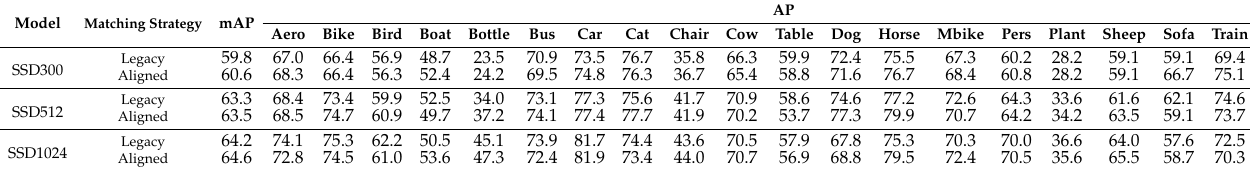
Table 3. SSD’s performance on Pascal VOC.